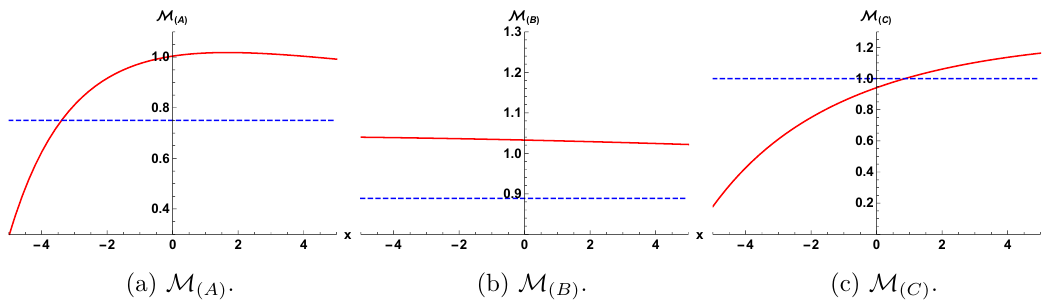
(red lines) for the microstate fam- ( A,B,C )